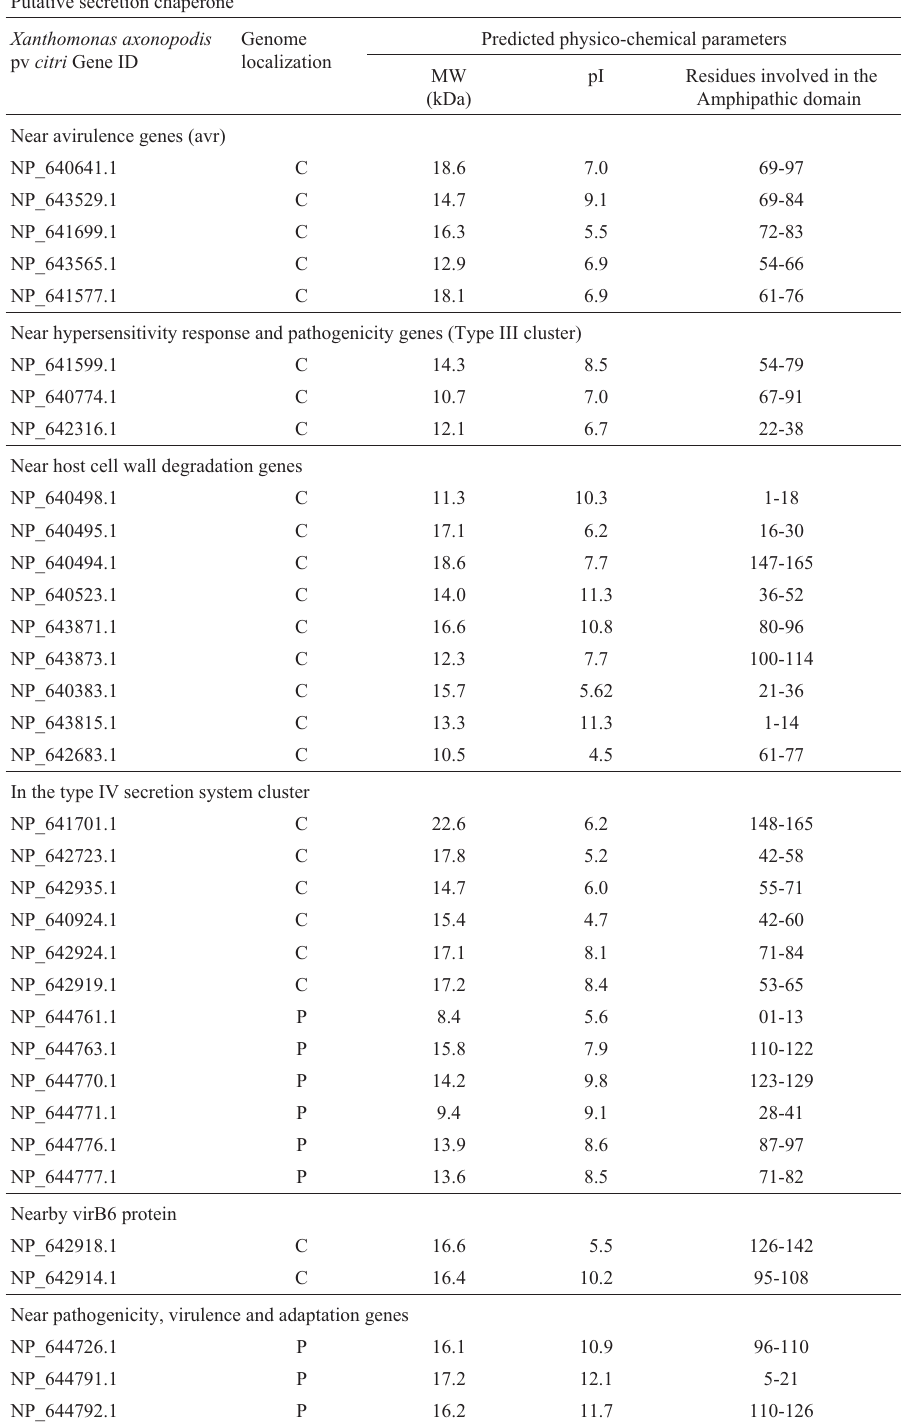
Table 2 - Potential type III chaperone genes determined by analysis of sequences localized near pathogenic and virulence clusters. Hypothetical genes in the Xanthomonas axonopodis pv citri genome (da Silva et al. , 2002) localized near (< 1.5 kb) pathogenic and virulence clusters, were individually analyzed with the programs described in the Material and Methods section for potential physico-chemical characteristics similar to type III chaperones. This method allowed the identification of 34 potential secretion system chaperone genes, 25 localized at the chromosome and 9 localized at the two plasmids, pXAC33 and